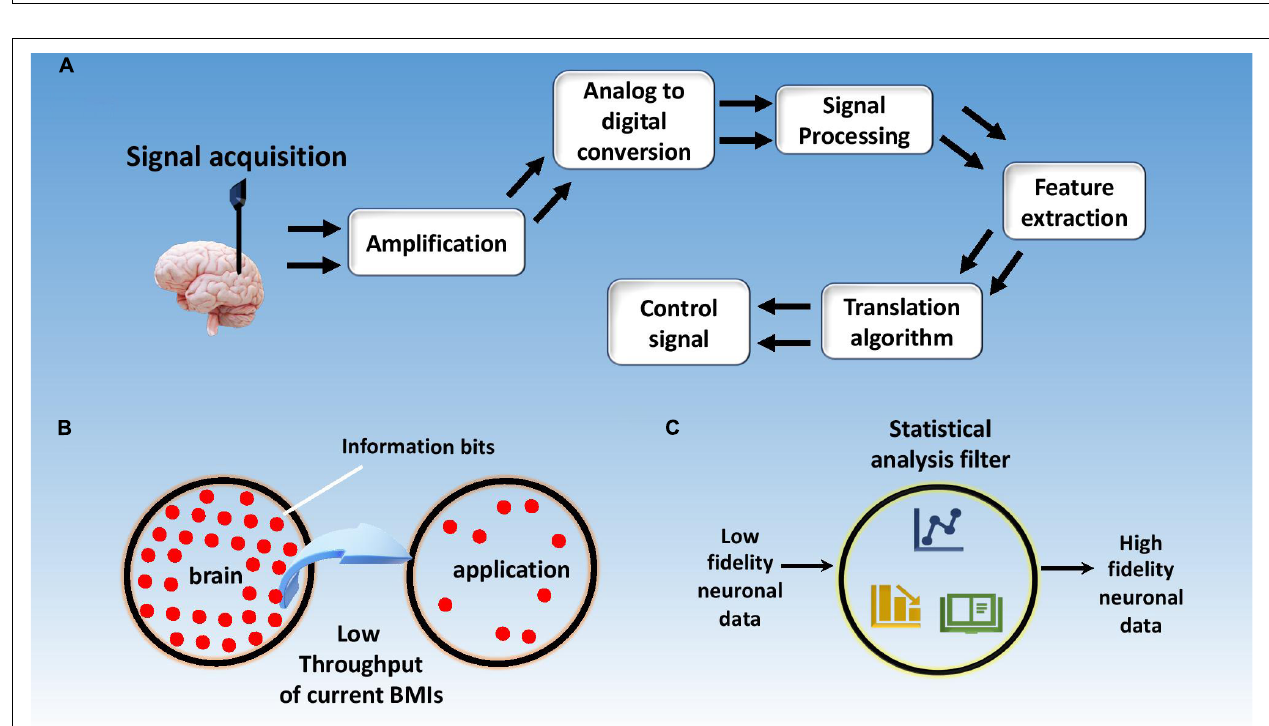
FIGURE 11 | Signal processing schematics and challenges. (A) Schematics of signal processing steps involved in neural data decoding; (B) current BMIs having a limited data transfer rate form brain to application; (C) neural data with high functional dimensionality need go through a rigorous statistical analysis to avoid false positive